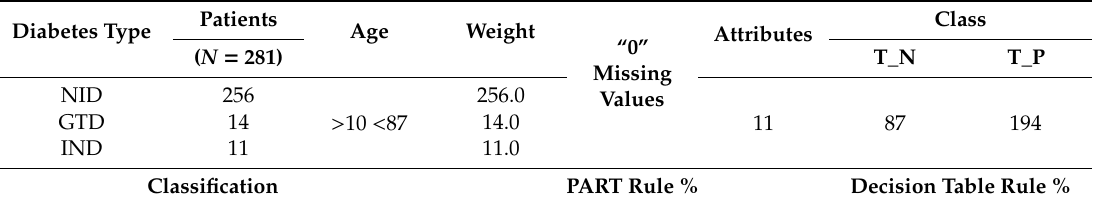
Table 1. Diabetes type and the number of patients classified for the Rule assessment. Diabetes Type